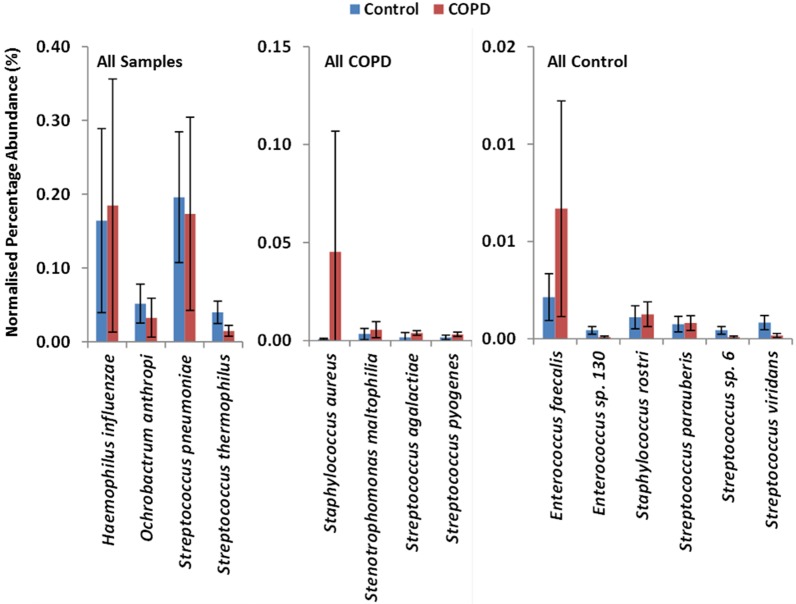
‘Core microbiome’ differences between Control and COPD participants.Abundance of the 14 bacterial species that constitute the ‘core microbiome’ in Control participants and COPD patients. Four bacterial species were found in all samples from both groups, four species were found in all of the COPD samples but not all of the Control samples, and six species were found in all of the Control samples but not all of the COPD samples. There was no bacterial species that was common to all samples in one of the two groups, but unique to that group.